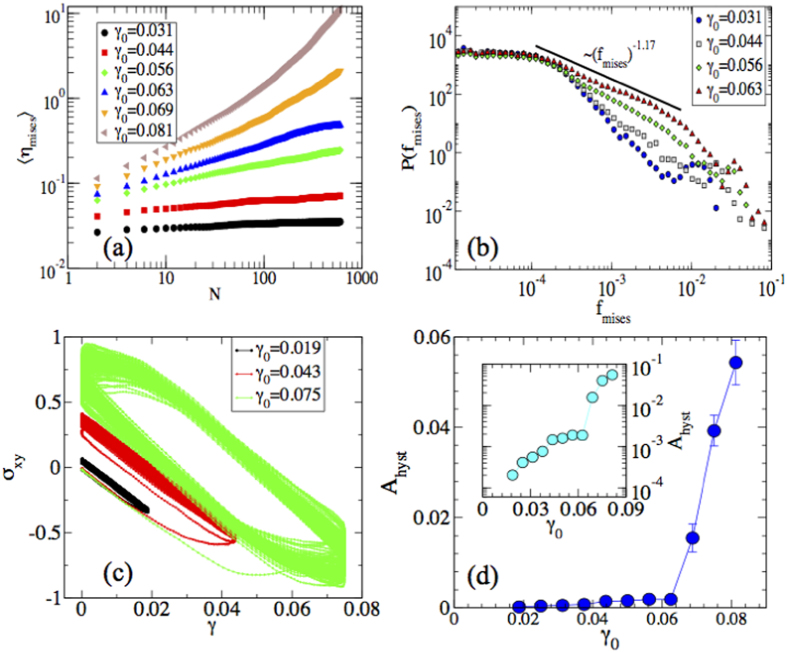
Plastic deformation.(a) Average shear strain 〈ηmises〉 is shown as a function of N for different values of strain amplitude γ0. (b) Probability distribution of fmises for different values of strain amplitude γ0. (c) Shear stress σxy is shown as a function of applied strain γ. (d) Area of the hysteresis loop Ahyst obtained from (c) is plotted against strain amplitude. Inset shows the log-lin plot for the clarity.